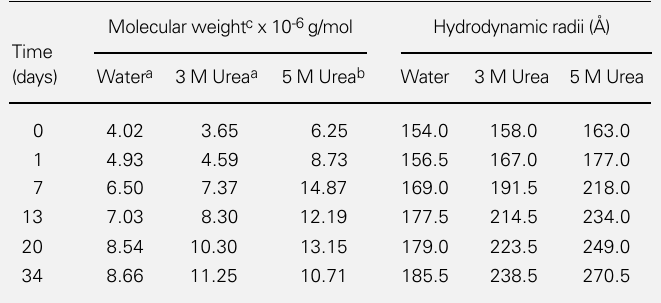
Table 3 - Molecular weight and hydrodynamic radii of HERQUAT vesicles as a function of incubation time and urea